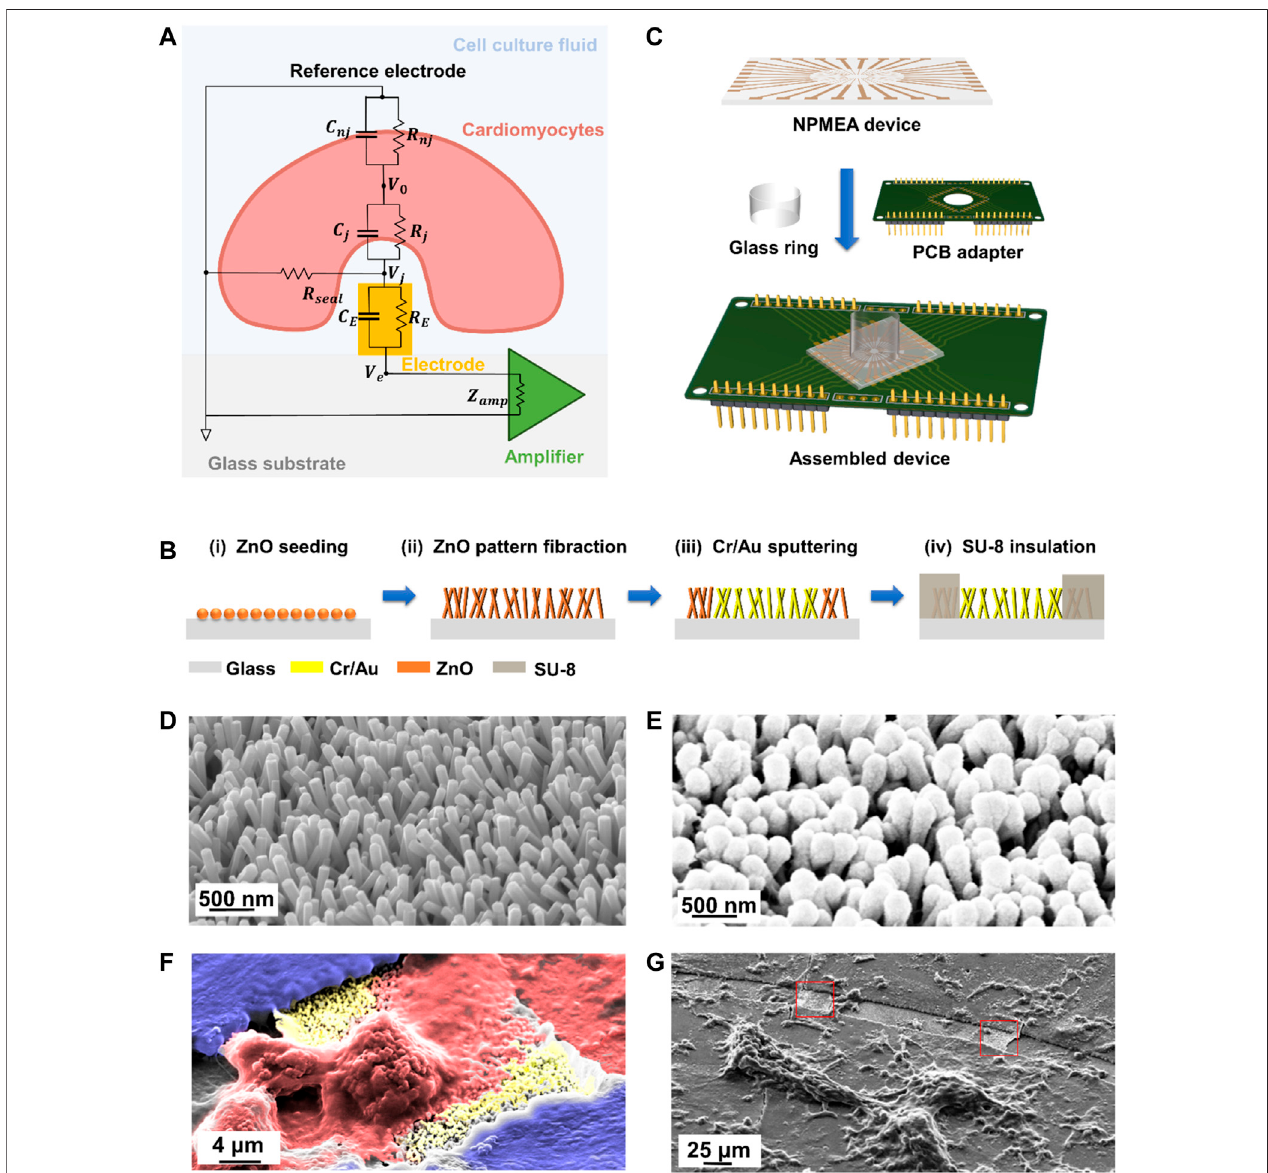
FIGURE 2 | NPMEA for biosensing of cardiomyocytes. (A) The equivalent circuit between cardiomyocytes and nanoelectrodes. The cardiomyocyte (light red) residesonasensingelectrode(orange)integratedintheculturesubstrate(grey).Cellculturemedium(lightblue) fi llthegapbetweenthecellmembraneandtheelectrode- substrate. (B) Fabrication process fl ow tofabricate NPMEA. (i)Sputter ZnO seedlayer on theglass substrate. (ii) Synthesis of ZnOnanopatterns based on hydrothermal reaction. (iii) Form a metal layer on the nano pattern by photolithography and sputtering. (iv) Pattern SU-8 layer to the non-electrode area for insulation by photolithography. (C) Fix the nanopatterned microelectrode array device to the PCB with PDMS, connect the matching pad of the device and the PCB with conductive silver glue, and then glue the glass ring to the center of the device with PDMS. (D) Scanning electron microscope (SEM) image of the ZnO pattern by the hydrothermal growth, corresponding to 2B(ii). (E) SEM image of the ZnO pattern after Cr/Au sputtering, corresponding to 2B(iii). (F) Colored SEM image of cardiomyocyte (red) on nanopatterned electrodes (yellow). (G) SEM image of NPMEA cultured with cardiomyocytes. Exposed nanopatterned microelectrodes are shown in the red